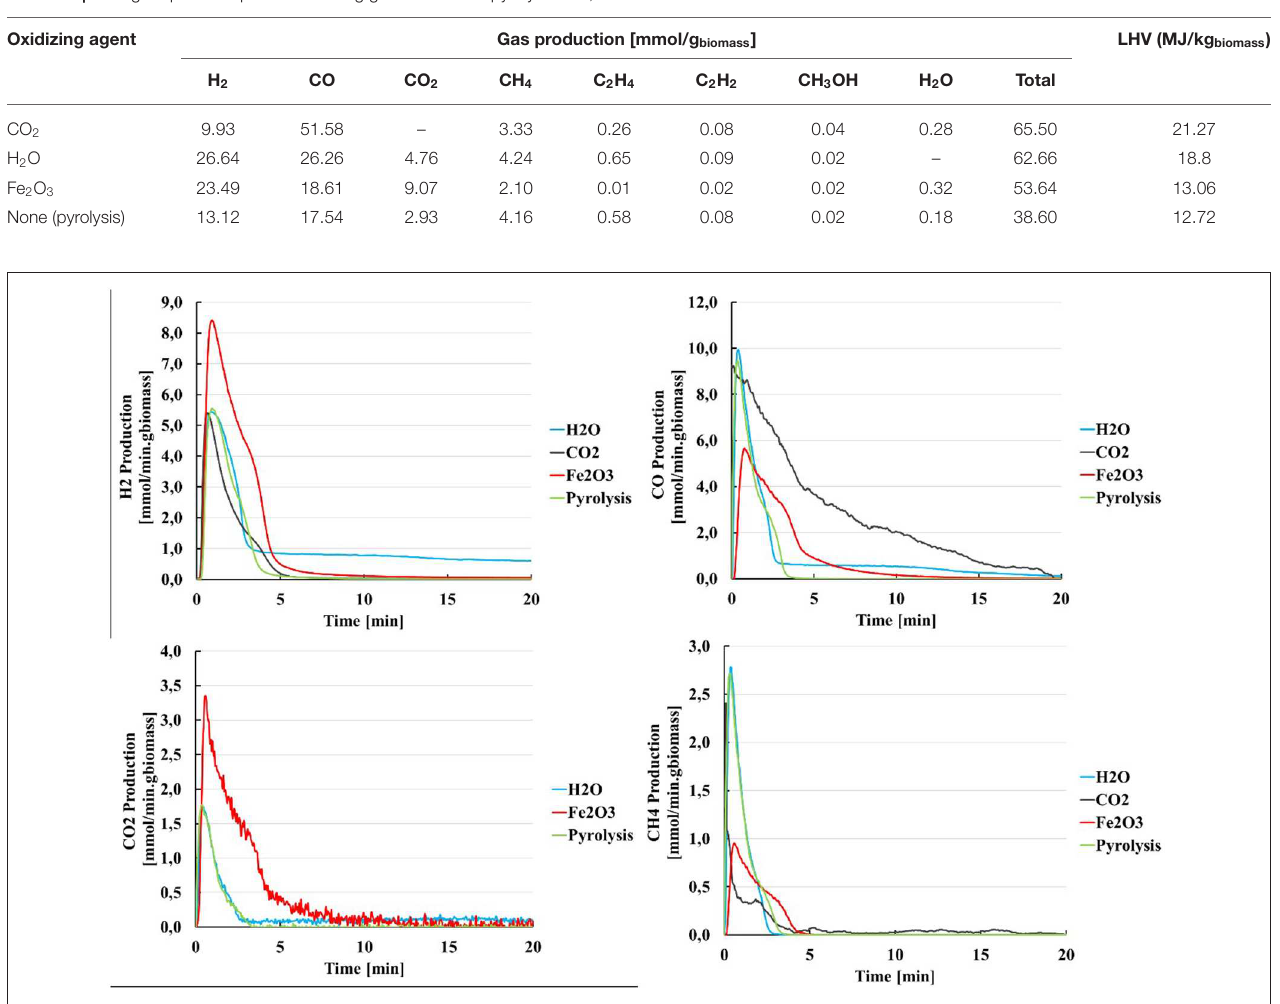
FIGURE 7 | Evolution of the gas production during gasification with CO 2 , H 2 O, and Fe 2 O 3 and pyrolysis of the batch of biomass.